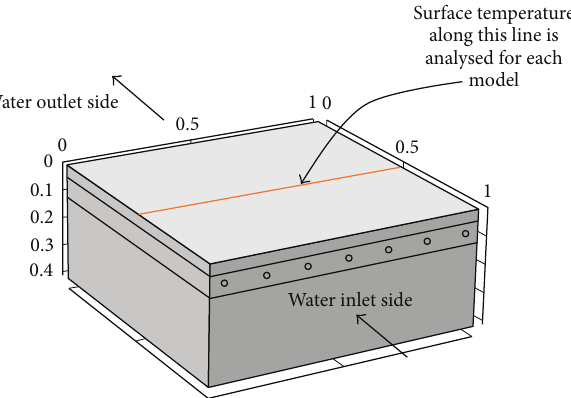
Figure 7: Surface temperature collection line and water inlet and outlet region in straight pipe arrangement.